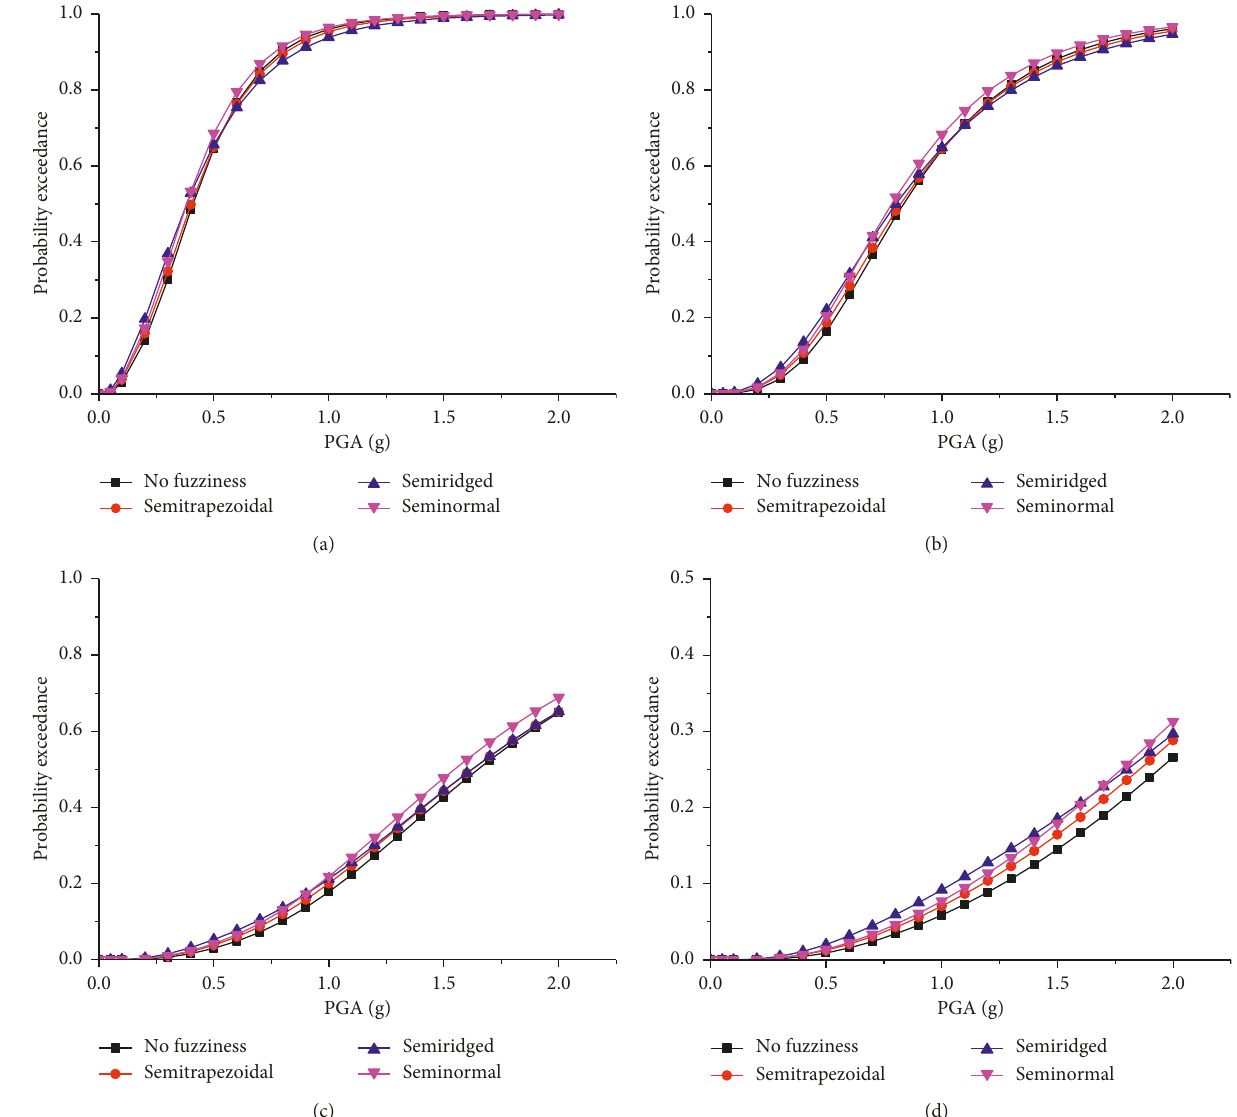
Figure 9: System fragility curves based on fuzzy failure criteria. (a) Slight damage. (b) Moderate damage. (c) Extensive damage. (d) Complete